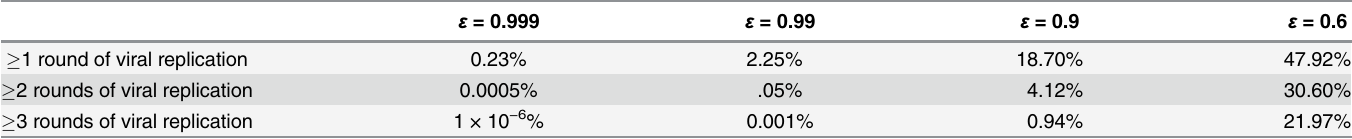
Table 2. Probability of at least one, two, or three rounds of viral replication, following the activation of a single latently infected cell, depending on the drug effi- cacy ε = 0.999, 0.99, 0.9, and 0.6, which are associated with different reproductive ratios R , 0.0023, 0.023, 0.23, and 0.92, respectively, and give different ini- tial viral loads V 0 , 3 copies/mL, 3.1 copies/mL, 4 copies/mL, and 38 copies/mL,